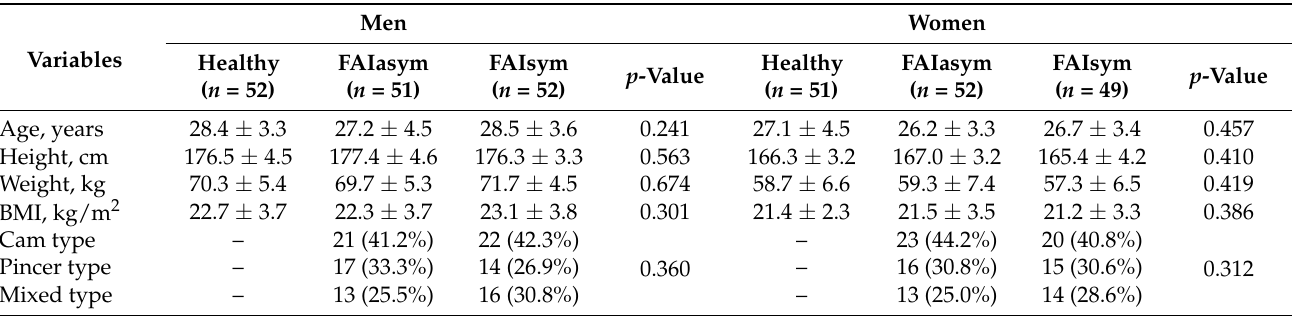
Table 1. General characteristics of